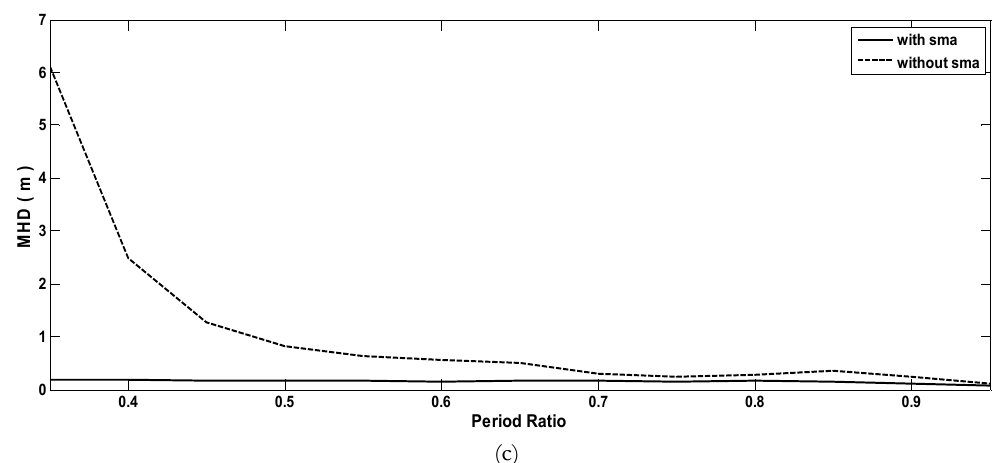
Figure 10: Comparison between MHD when using SMA and as–built bridge at various period ratios for the three hinges, (a) Hinge 1; (b) Hinge 2; (c) Hinge 3.